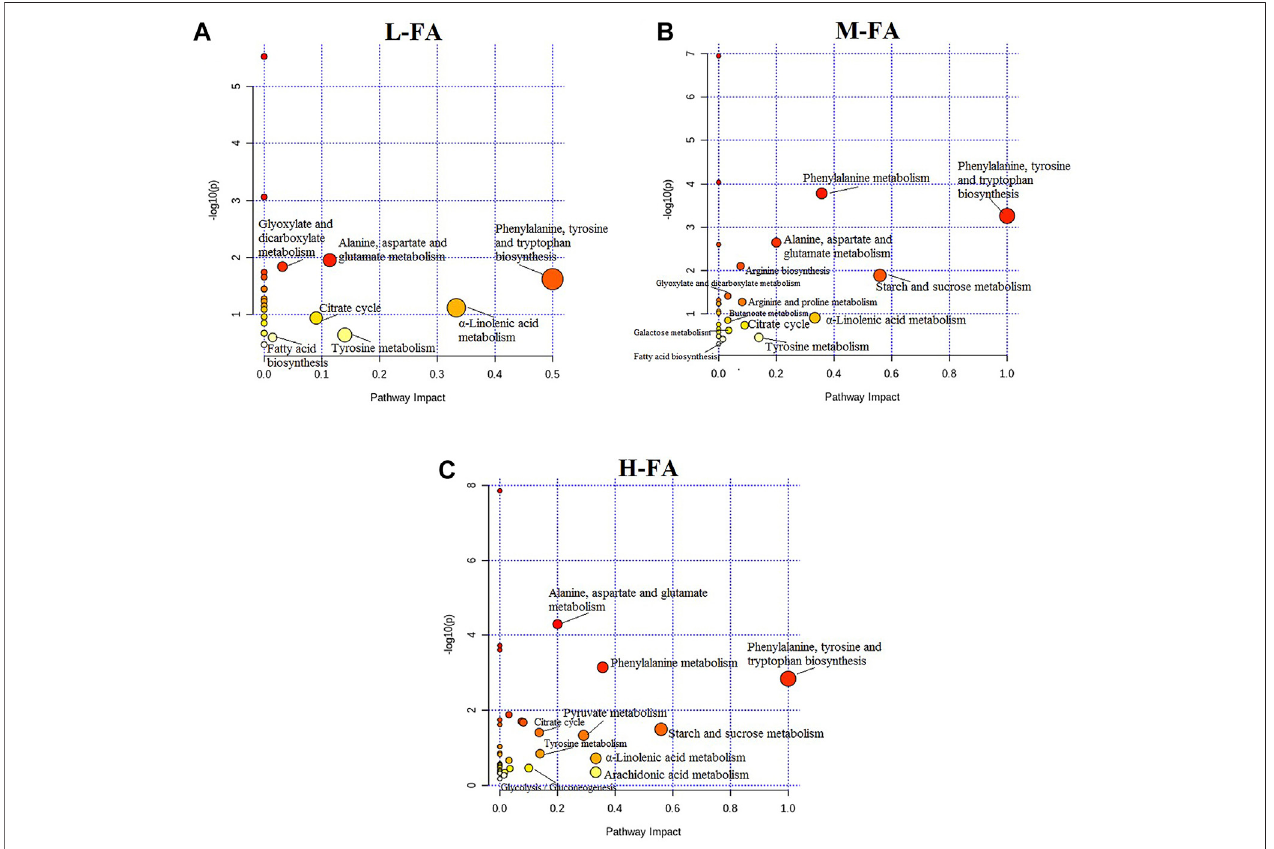
FIGURE 5 | The pathways associated with differential metabolites in response to the low, middle, and high dosage treatment of folic acid.